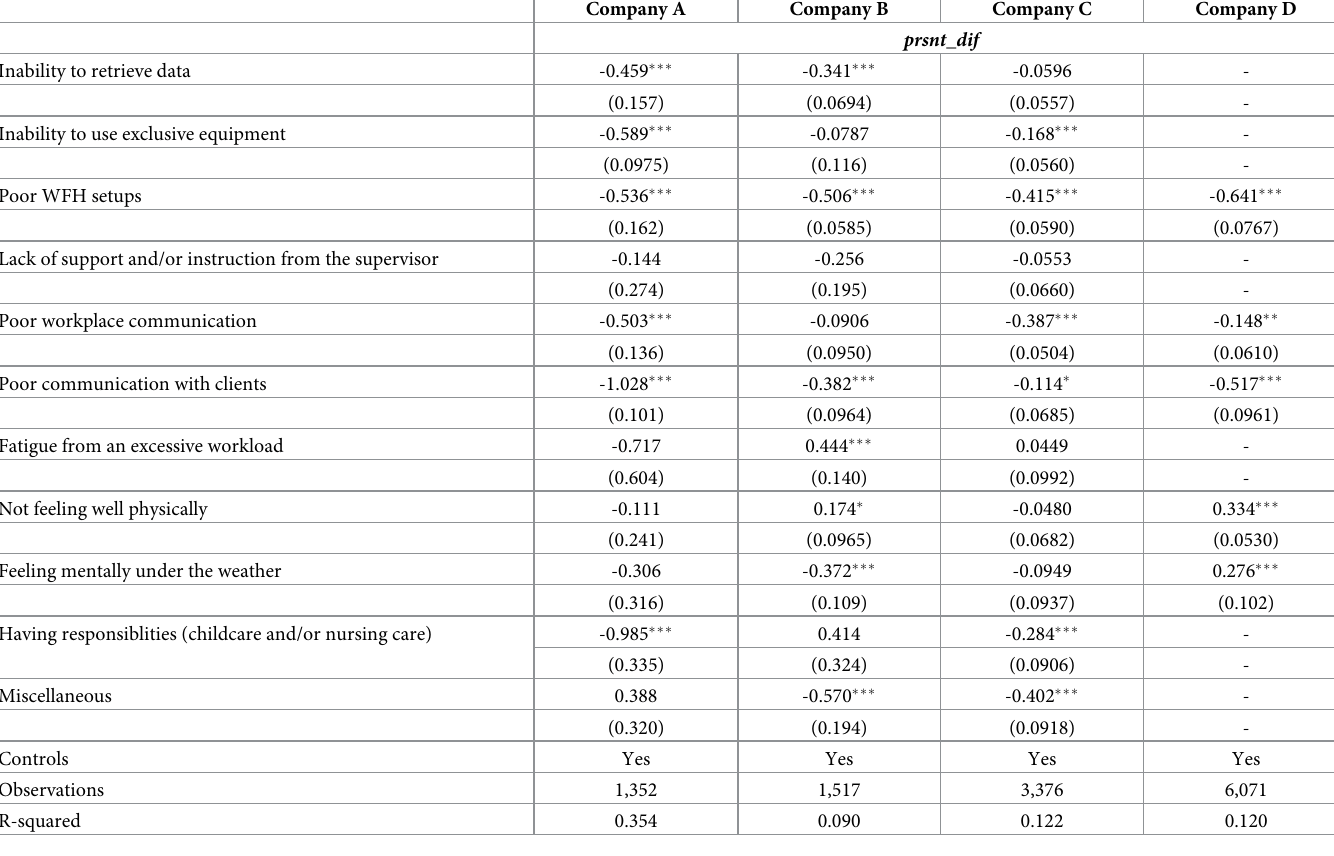
Table 4. Regression of productivity changes on the perceived factors of productivity